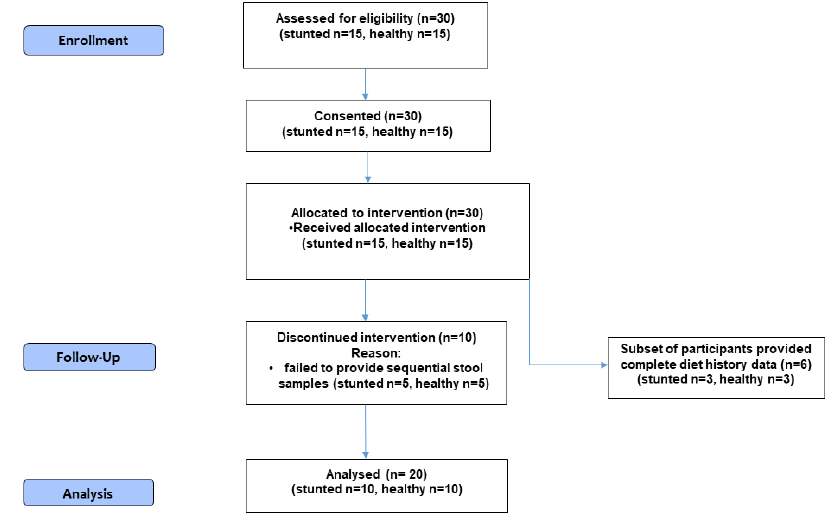
Figure 1. Participant flow diagram.